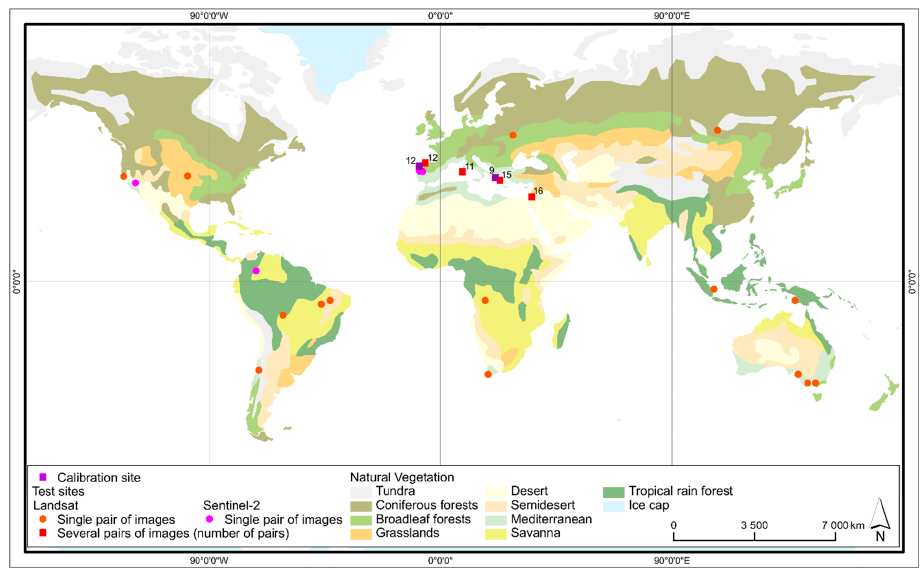
Figure 1. Distribution of calibration and test sites.